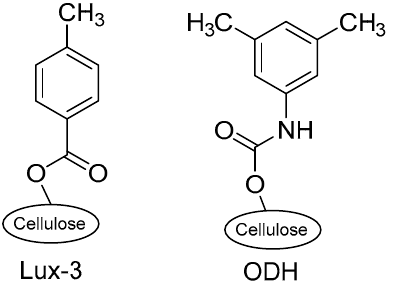
Figure 3. Chemical structures of LUX 3 ® and CHIRALCEL-ODH ® CSPs. Both LUX cellulose-3 ® and CHIRALCEL-ODH ® are cellulose-based coated columns with tris(4-methylbenzoate) and tris(3,5-dimethylphenylcarbamate) as chiral selector, re-